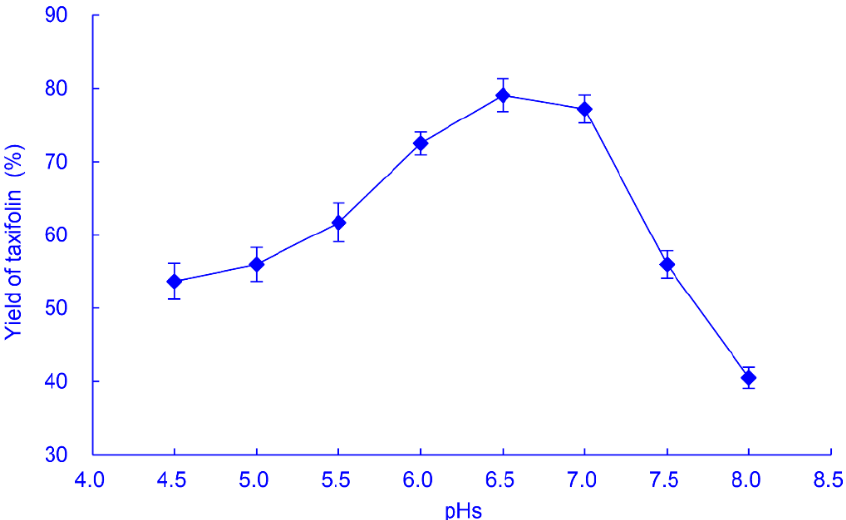
Figure 3. Effect of pH on the yield of taxifolin from biotransformation of astilbin by A. fumigatus SQH4. Biotransformation was performed at 30 °C with shaking at 200 r/min for 8 h, with 1 g/L astil- Biotransformation was performed at 30 ◦ C with shaking at 200 r/min for 8 h, with 1 g/L bin.